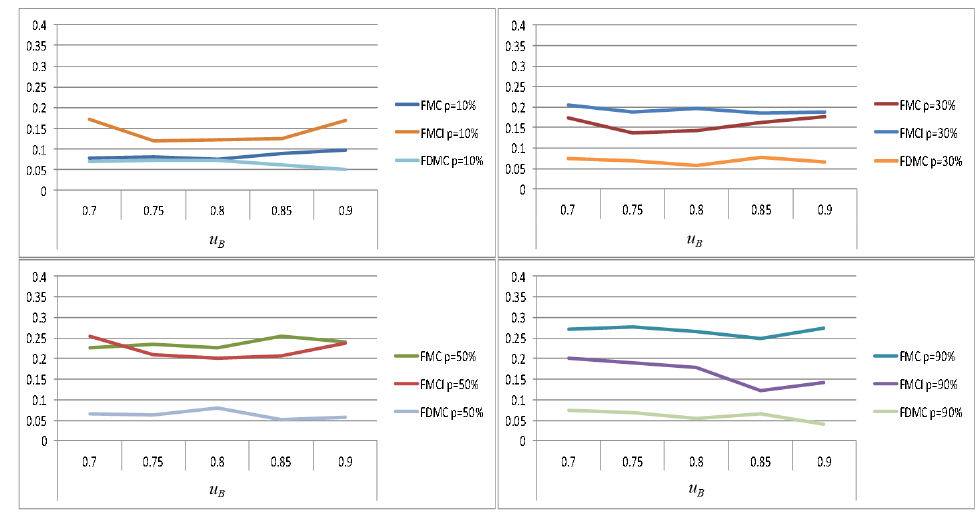
Figure 10. Horizontal comparison of switching cost results of each scheme under the same p